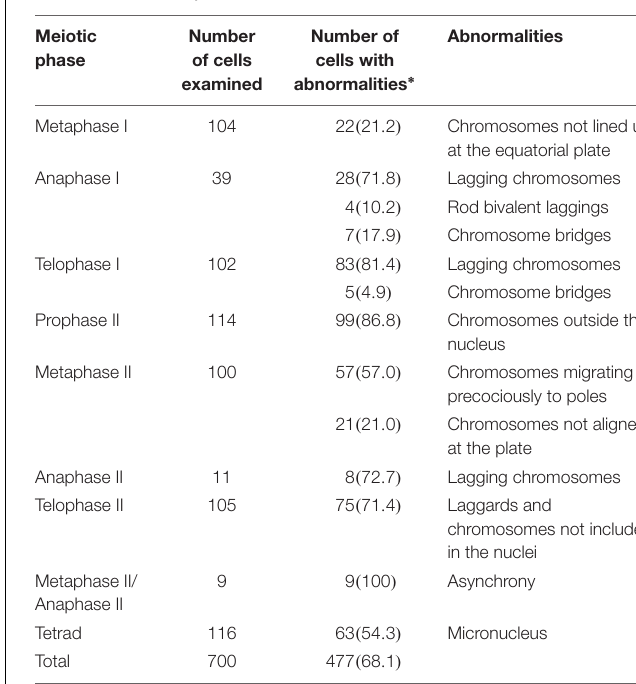
TABLE 1 | Meiotic abnormalities observed in pollen mother cells of the IACSP93-3046